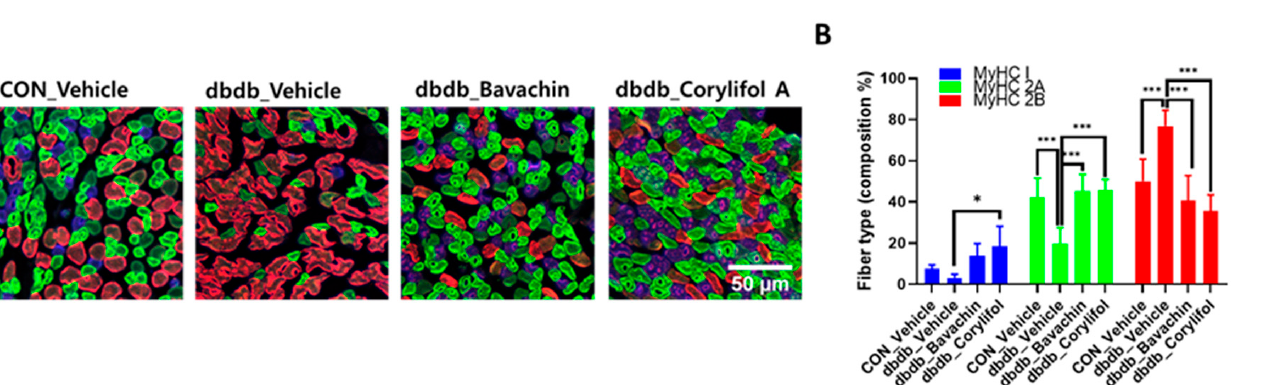
Figure 6. Bavachin and corylifol A induce the conversion of fast muscle fibers to slow muscle fibers in db/db mice. Twelve week old male db/db mice were administered bavachin (10 mg/kg) or corylifol A (10 mg/kg) for 40 d. ( A ) Representative images of MyHC immunofluorescence in GA muscle. Images were triple labeled for MyHC 1 (blue, type 1 fibers), MyHC 2A (green, type 2A fibers), and MyHC 2B (red, type 2B fibers). Scale bar indicates 50 μ m. Images were captured at 600× magnification. ( B ) Proportion of MyHC isoform-specific fibers. Protein expression levels in the GA muscles were determined via western blotting. ( C ) Protein expression levels of MyHC 1, MyHC 2B, troponin I fast skeletal muscle (TnI-FS) and troponin I slow skeletal muscle (TnI-SS). All data are represented as the mean ± S.E.M., n = 6/group; * p < 0.05, ** p < 0.01, *** p < 0.001; nonparametric analysis of variance, followed by Kruskal-Wallis test. 3.6. Bavachin and Corylifol a Improve the Mitochondrial Dynamics via the AMPK α Signaling Pathway in db/db Mice Mitochondrial biogenesis and dynamics are critical for mitochondrial function [32]. In addition, changes in muscle fiber composition induced by bavachin and corylifol A are associated with mitochondrial number and function [33]. We investigated mitochondrial biogenesis and dynamics. PGC-1 α , NRF1, and TFAM expression levels were significantly decreased in db/db mice as a result of reduced AMPK α phosphorylation (Figure 7A,B). Bavachin and corylifol A increased AMPK α phosphorylation and the expression levels of PGC-1 α , NRF1, and TFAM (Figure 7A,B). Expression levels displayed no difference between the bavachin and corylifol A groups (Figure 7A,B). Accurate regulation of mitochondrial morphology is important for a smooth supply of intracellular energy, and quantitative and qualitative regulation of mitochondrial morphology-regulating proteins is required to achieve an appropriate balance between mitochondrial fission and fusion processes [34–36]. Expression levels of all fusion (OPA1, MFN1, and MFN2) and fission (FIS1 and DRP1)-related proteins were decreased in db/db mice compared with those in the control mice (Figure 7C,D). Similarly, the expression levels of all fusion (OPA1, MFN1, and MFN2) and fission (FIS1 and DRP1)-related proteins were decreased in db/db mice compared to those in the control mice (Figure 7C,D). However, this decrease in expression, except for that of OPA1, in the case of corylifol A administration, was significantly increased by both treatments (Figure 7C,D).